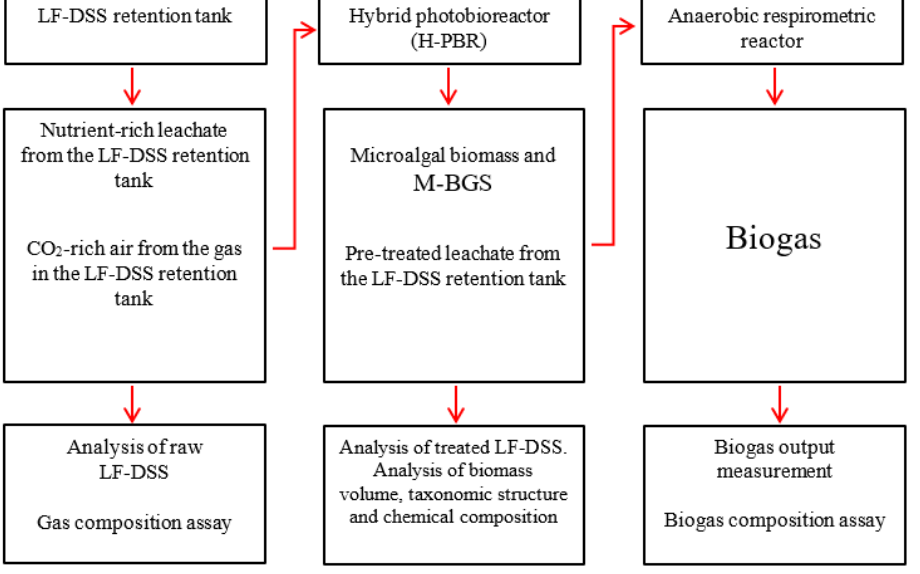
Figure 1. Flowchart of the experiment.